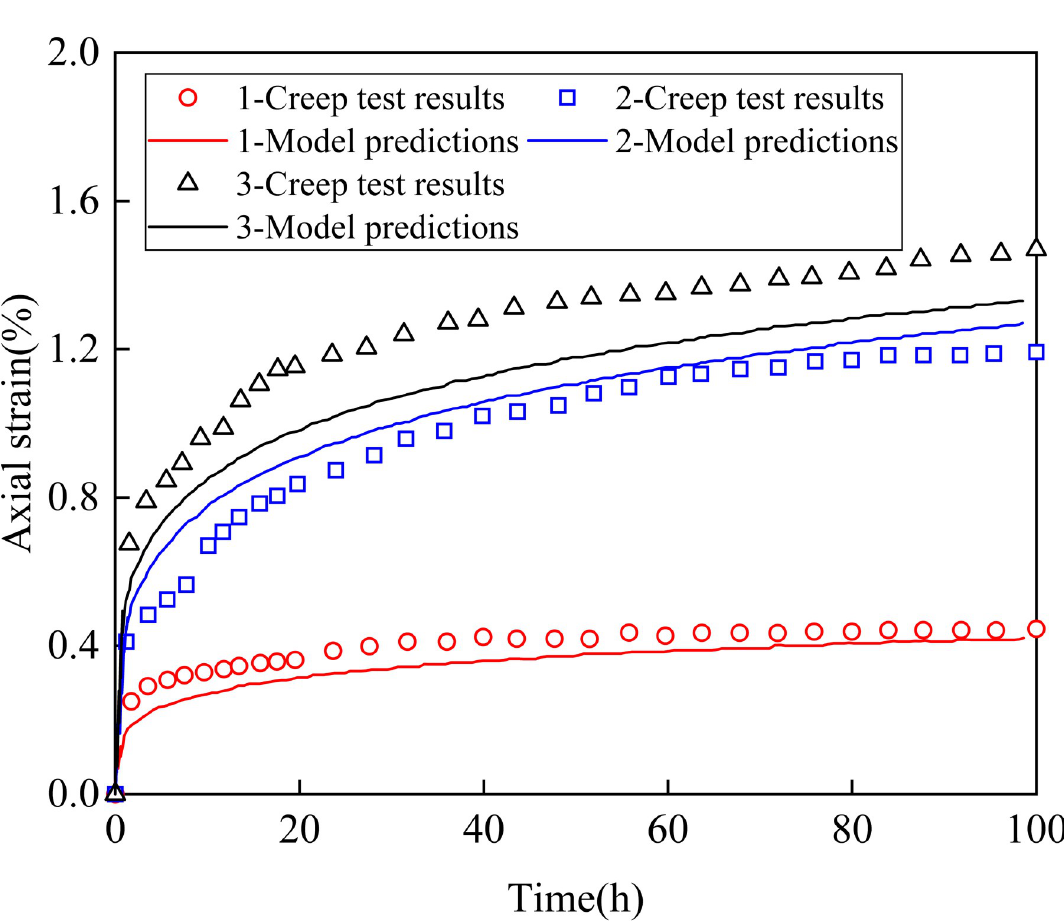
Fig 4. Comparison curve between the fractional differential constitutive model and undrained triaxial creep test (Condition 1, confining stress: 100 kPa, stress difference ratio: 0.25; Condition 2, confining stress: 100 kPa, stress difference ratio: 0.50; Condition 3, confining stress: 200 kPa, stress difference ratio: